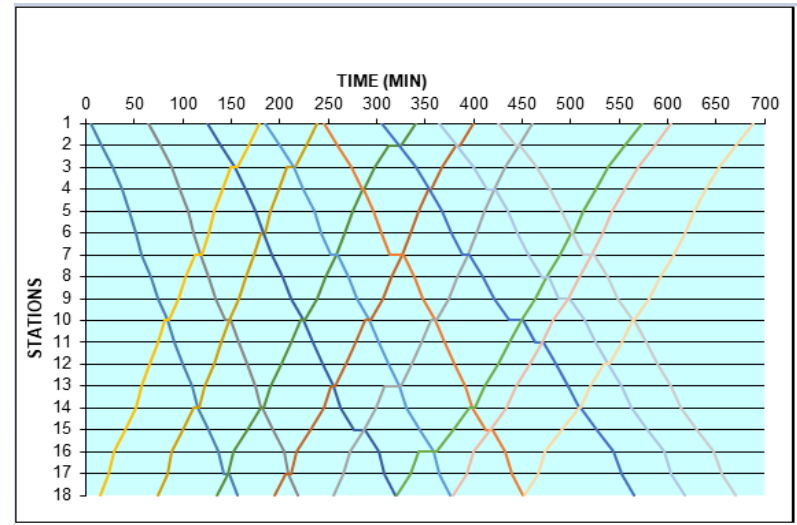
Figure 4. The solved (optimal) state of the special 8 + 8 train instance. Table 10. Minimum running times (minutes).